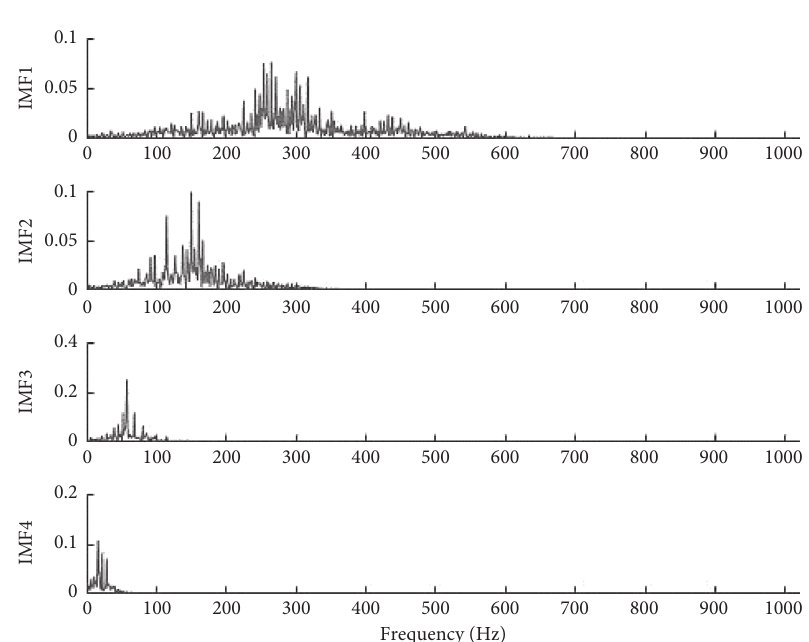
Figure 8: Amplitude-frequency of